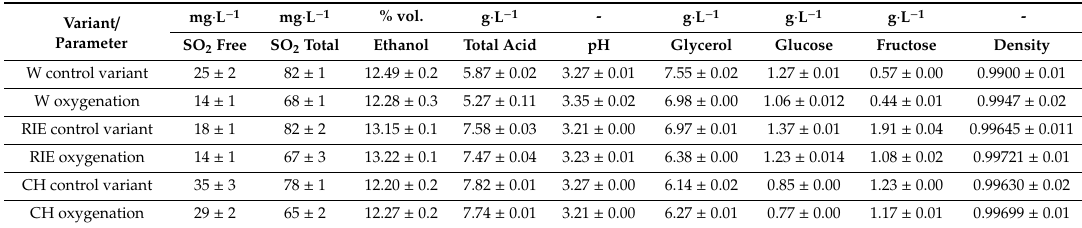
Table 3. Basic physicochemical parameters of wine from individual variants in 2016 with the standard deviations.